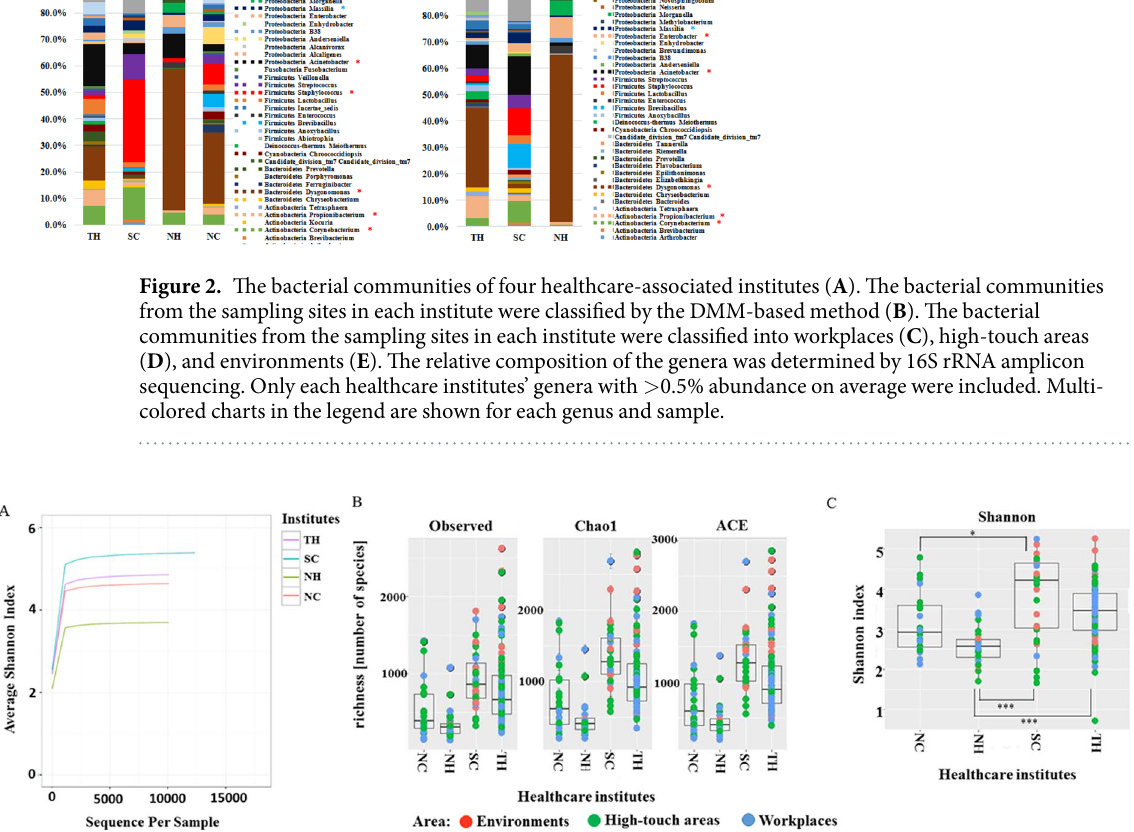
Figure 3. Alpha-diversity values with different sequencing depths were measured using Shannon index average scores ( A ). Alpha-diversity measurements for communities from the four healthcare institutes (TH, SC, NH, and NC). Alpha-diversity metrics were employed (richness and Shannon index) ( B , C ). The bottom and top of each box are the first and third quartiles, respectively, and the band inside the box is the median. The whiskers represent one standard deviation above and below the mean of the data. Statistical testing was based on the Wilcoxon rank-sum test ( * p < 0.05, *** p <